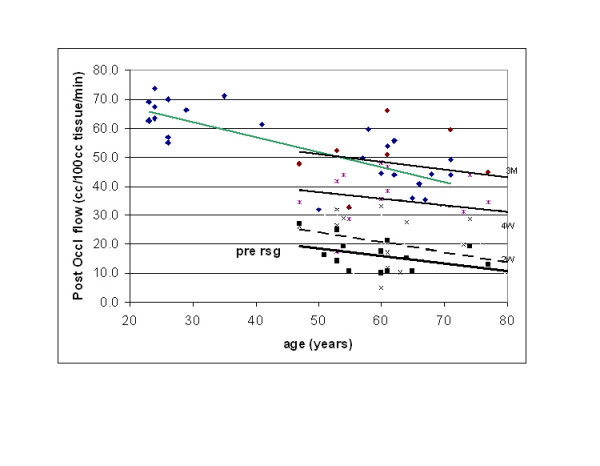
This figure illustrates the excess flow above rest during a two minute period after the release of an occlusion cuff on the brachial artery of control subjects and subjects with diabetes. Individual data points are shown on control subjects and subjects with diabetes prior to initiation of a three month administration of rosiglitazone (pre rsg) and after 2 weeks (2 w), four weeks (4 w), and three months (3 m). Data is plotted in relationship to the age of the subject. The regression lines are calculated by the method of least squares. On the control subjects the regression line was flow = -0.518 age + 77.78. Prior to administration of rosiglitazone of the subjects with diabetes the regression equation was flow = -0.253 age + 31.01. After two weeks of administration of rosiglitazone the regression equation was blood flow = -0.348 age + 41.6. After 4 weeks of rosiglitazone the regression equation was blood flow = -0.243 age + 50.27. Finally after 3 months of rosiglitazone was post occlusion flow = -0.274 age + 64.94